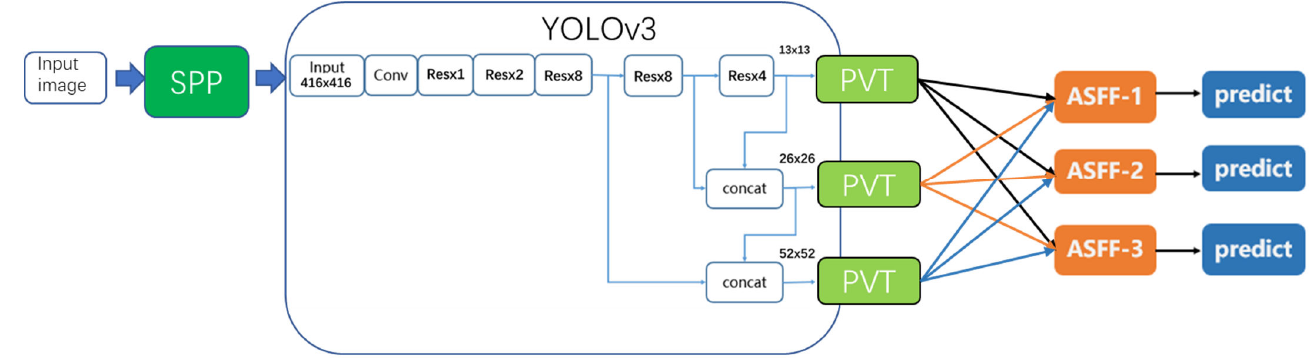
Figure 2. The overall framework of our work. SPP means integrating spatial pyramid pooling, ASFF means adaptive spatial feature fusion and the detection algorithm is based on the YOLOv3 network.